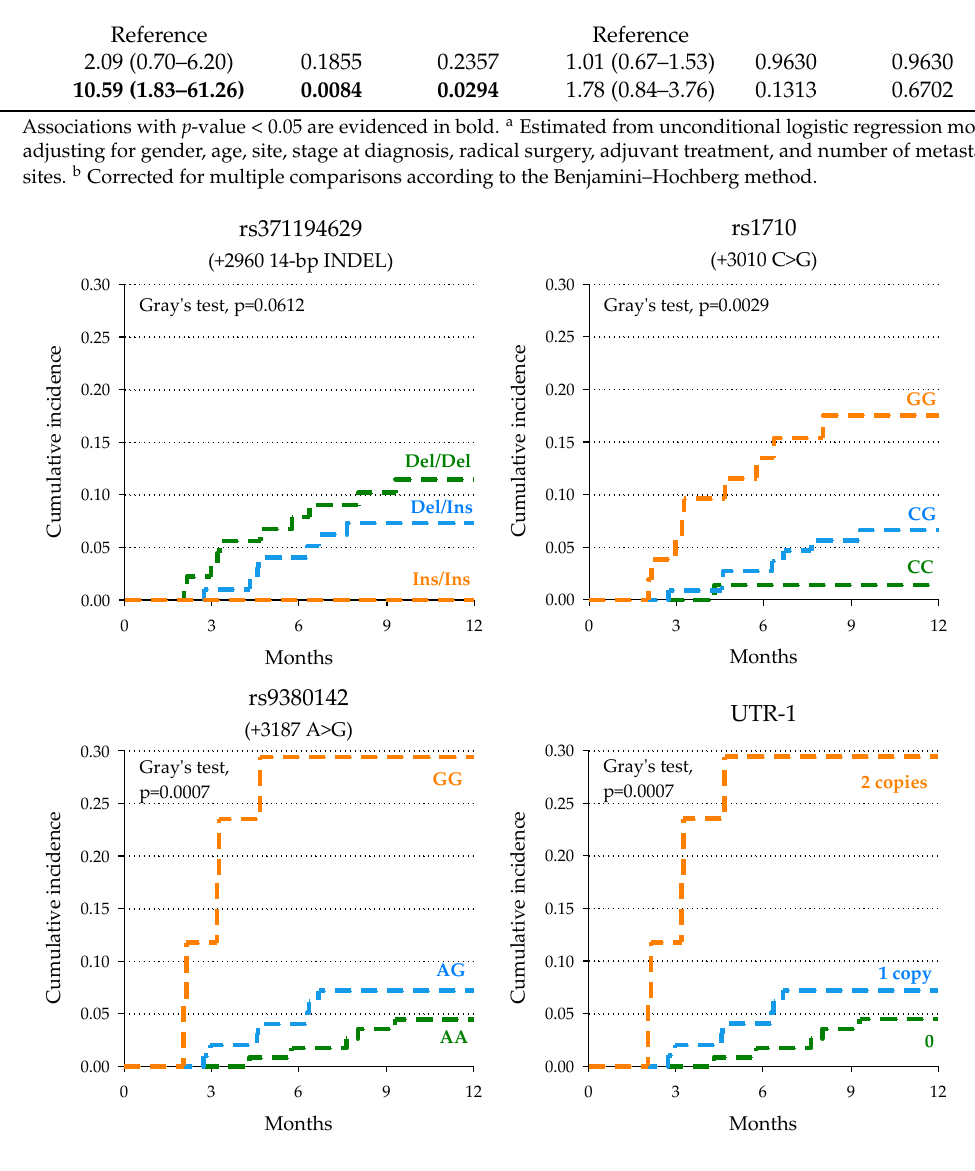
Figure 1. Kaplan – Meier estimate of cumulative incidence of complete response according to selected polymorphisms.